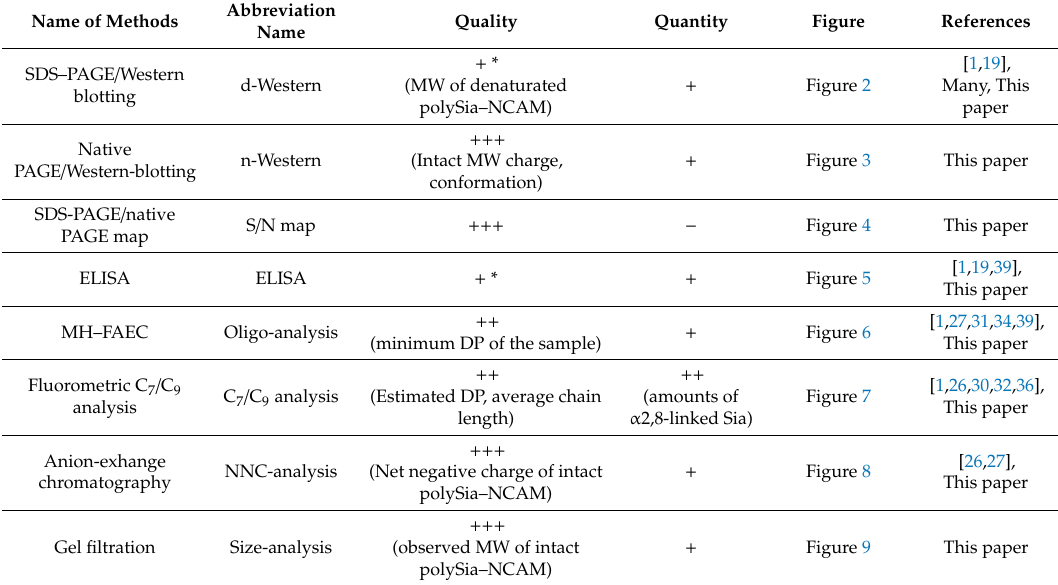
Table 1. Methods for the evaluation of